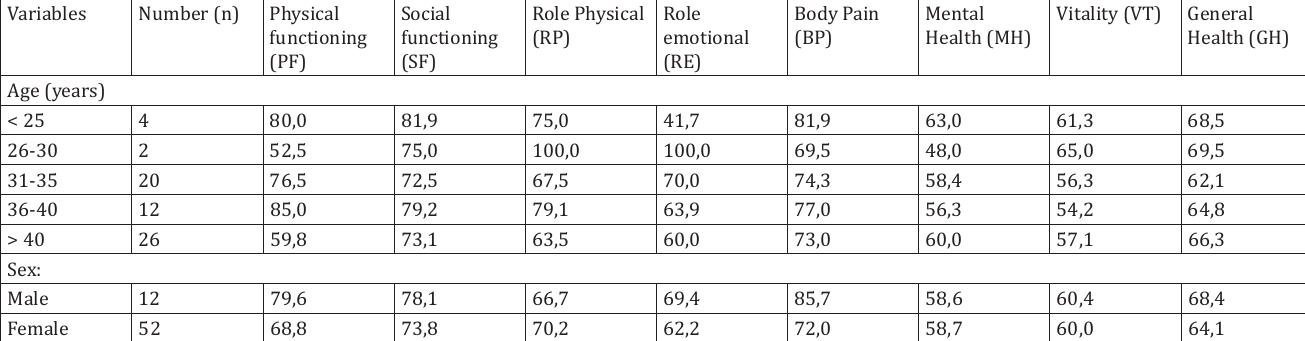
Table 4 Average scores on the SF-36 questionnaire dimensions concerning respondent gender and age.